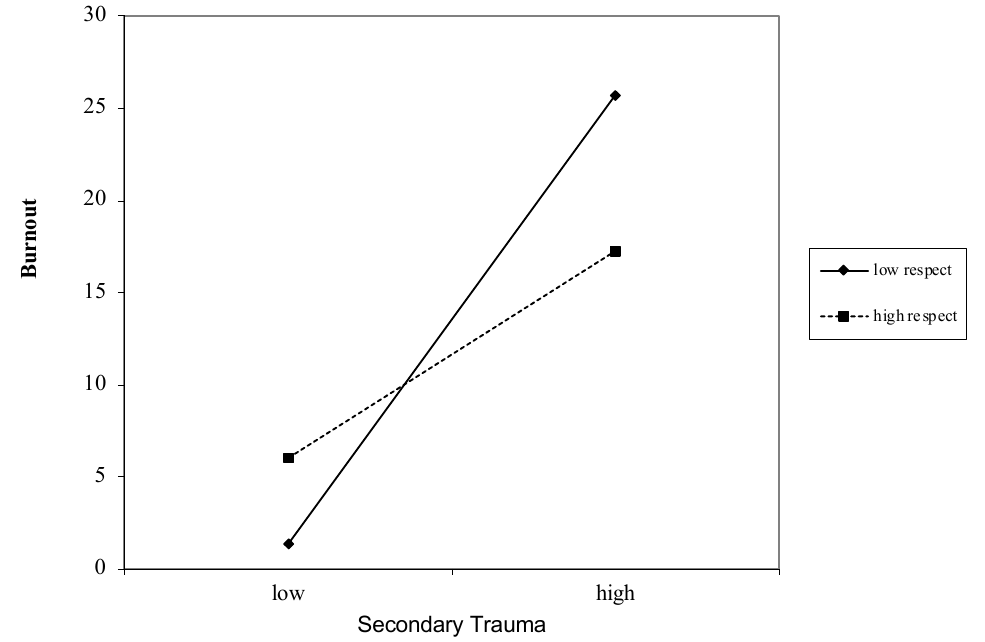
Figure 4. Graph of interaction plot between secondary trauma and respect. Perceived respect moderates the relationship between secondary trauma and burnout, such that those with low respect (1 SD below the mean) and high secondary trauma reported greater burnout.